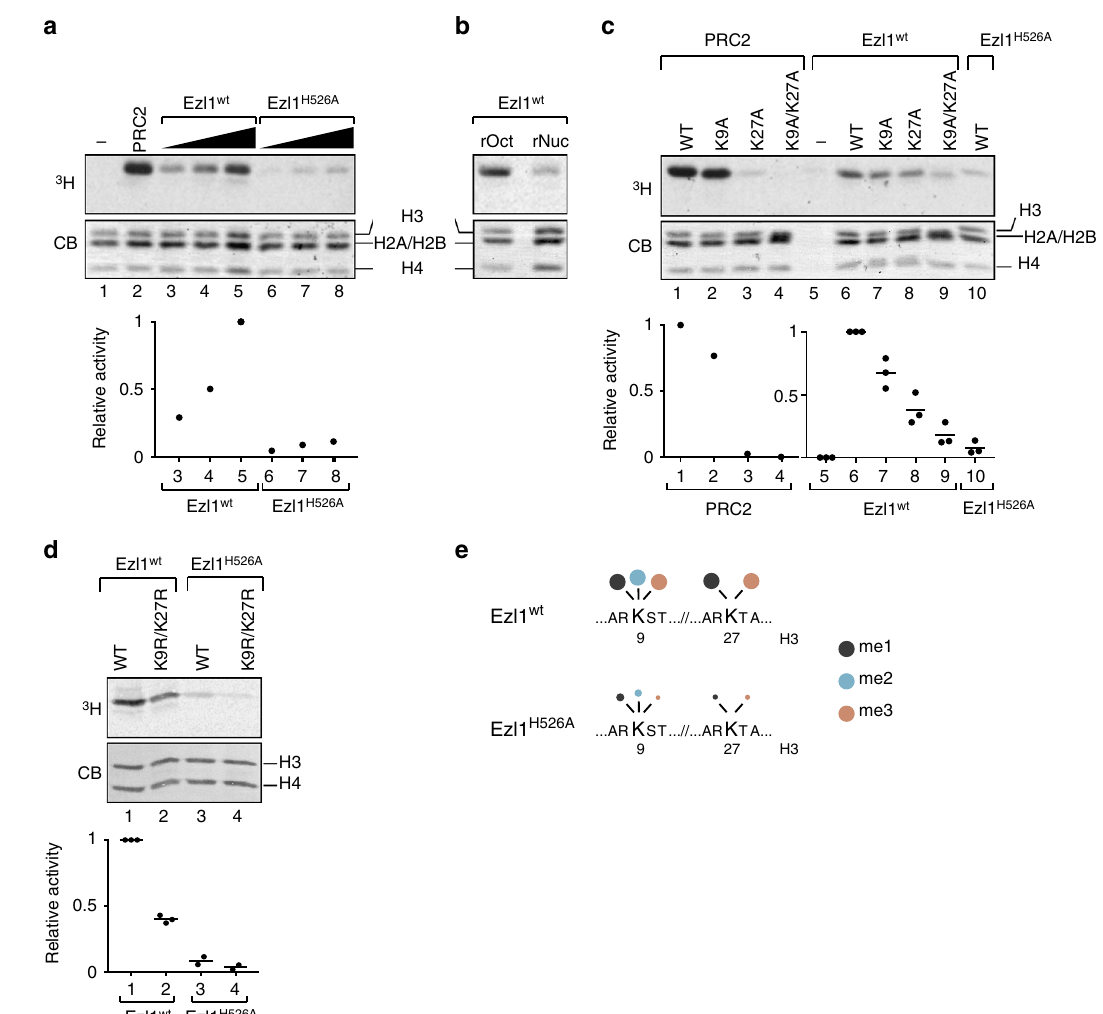
Fig. 2 Histone methyltransferase assay. Full-length wild-type GFP-Ezl1 wt and mutant GFP-Ezl1 H526A proteins were immunoprecipitated at 12 h after the onset of sexual events (see Supplementary Fig. 2) from Paramecium transformed cells, in which endogenous Ezl1 protein expression was speci fi cally depleted through RNA interference, and used for in vitro histone methyltransferase reactions ( a – c ). a Wild-type Xenopus recombinant histone octamers are used as substrates and S-adenosyl-[methyl 3H]-methionine as methyl donor. Af fi nity-puri fi ed recombinant PRC2 complex is used as a positive control. The same reactions with histone octamers only were performed as a negative control. Coomassie stain (CB, bottom panel) shows histones and the autoradiograph ( 3 H, top panel) indicates H3 histone methyltransferase activity. The graphs show relative quanti fi cation of histone methyltransferase signals analyzed by scintillation counting after SDS-PAGE. b Histone methyltransferase activity on recombinant histone octamers (rOct) and on oligonucleosomes (rNuc). c Substrate speci fi city. Histone methyltransferase assays were performed with recombinant histone octamers assembled with wild-type H3 histones or with H3 histones bearing a point mutation on lysine 9 (K9A) or on lysine 27 (K27A) or on both (K9A/K27A) on the same histone H3 tail. The same reaction without addition of histone octamers was performed as a negative control. For Ezl1 wt and Ezl1 H526A , the horizontal bars indicate the mean of three biological replicates (independent nuclear extracts). Circles indicate the individual data points. d Full-length 3xFLAG-HA tagged Ezl1 wt and Ezl1 H526A proteins were immunoprecipitated using a FLAG-HA double-af fi nity puri fi cation from Paramecium transformed cells, depleted for the endogenous Ezl1 protein in the case of the mutant FLAG-HA-Ezl1 H526A , and used in in vitro histone methyltransferase reactions (see Supplementary Fig.